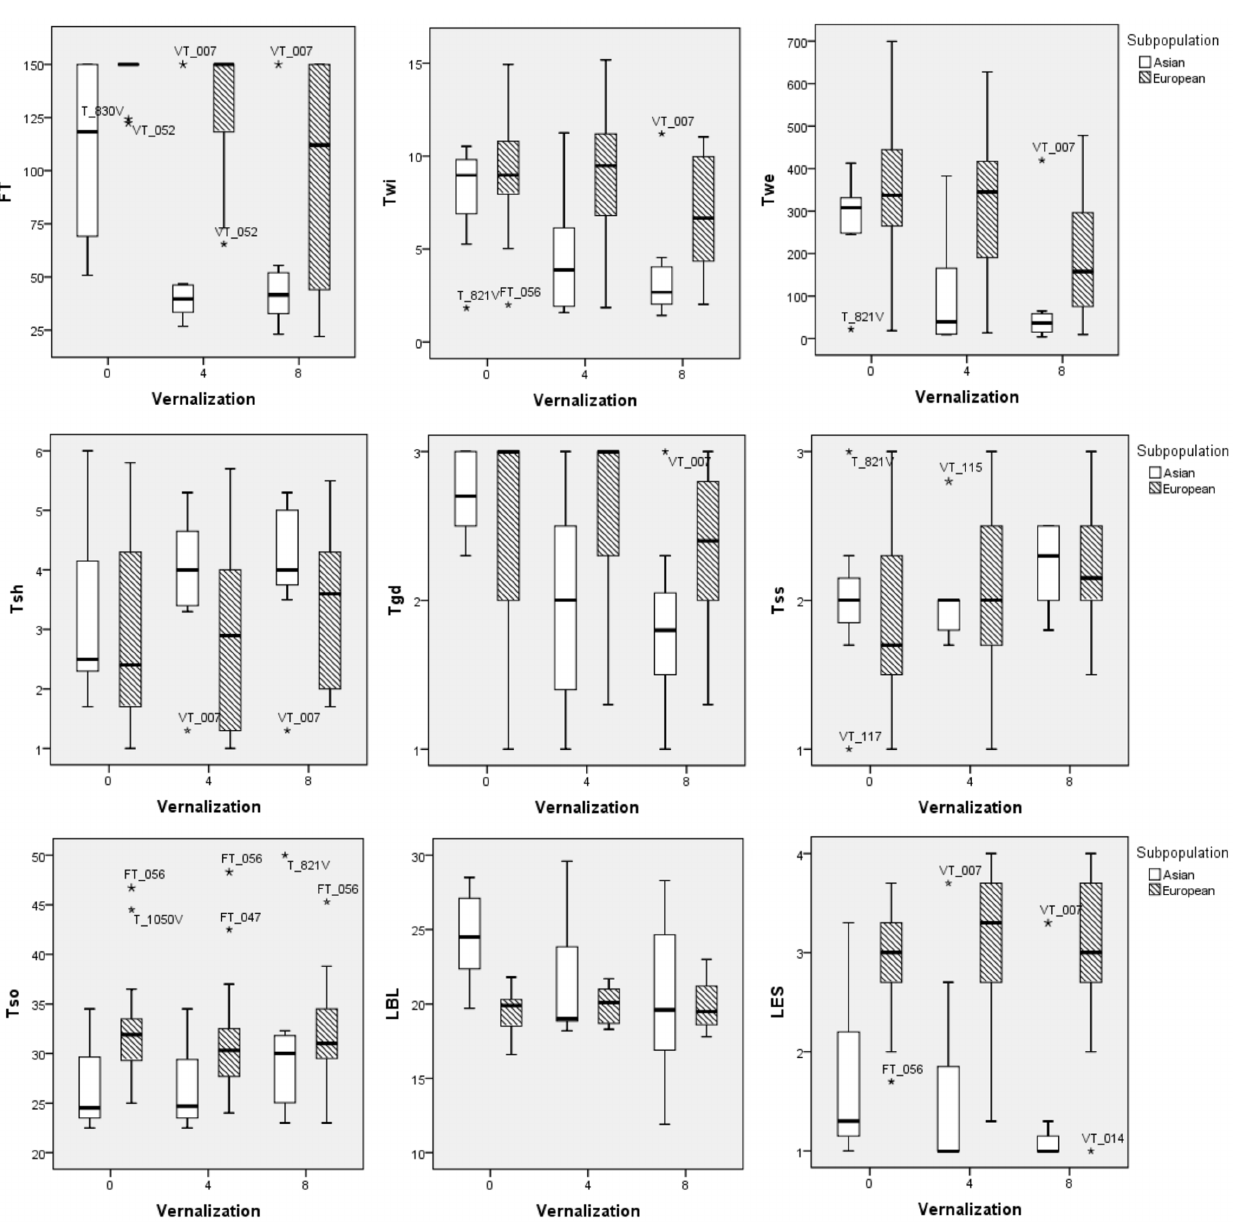
Figure 6. Boxplots showing vernalization responses of 29 turnip accessions for nine different phenotypic traits to no vernalization, four week vernalization and eight week vernalization. The presented traits are flowering time (FT), tuber width (Twi), tuber weight (Twe), tuber shoots number (Tsh), tuber growing depth (Tgd), tuber surface smoothness (Tss), tuber swelling onset (Tso), lamina blade length (LBL) and leaf edge shape (LES). Open and striped boxes stand for Asian and European subpopulation respectively. Outliers are marked using